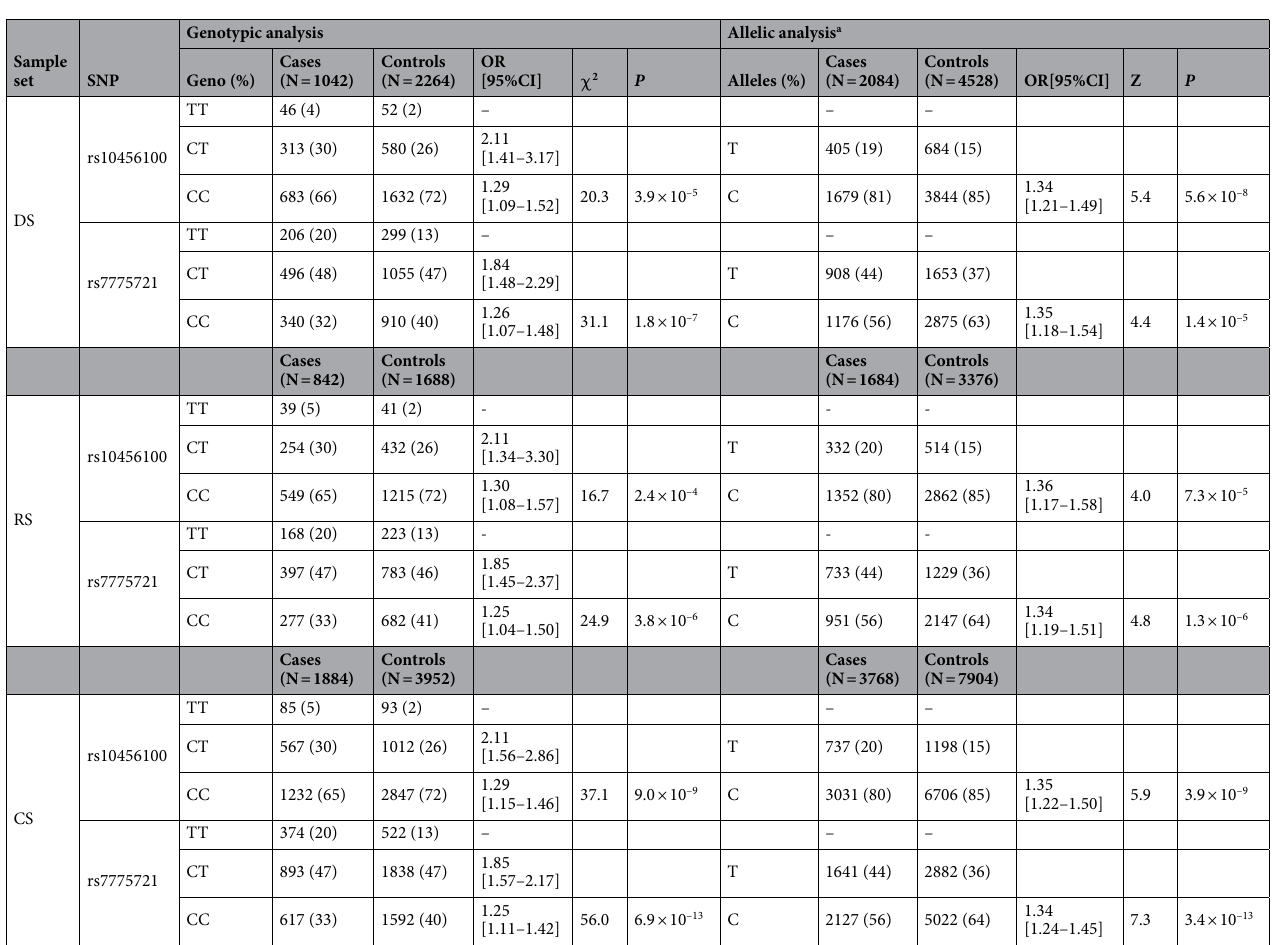
Table 2. Significant results for single marker based association analysis. DS: discovery stage; RS: replication stage; CS: combined set. Geno: Genotypes. Z: Z-statistics. a Logistic models were fitted for allelic analysis. OR with 95% confidence intervals and P values were adjusted by age and